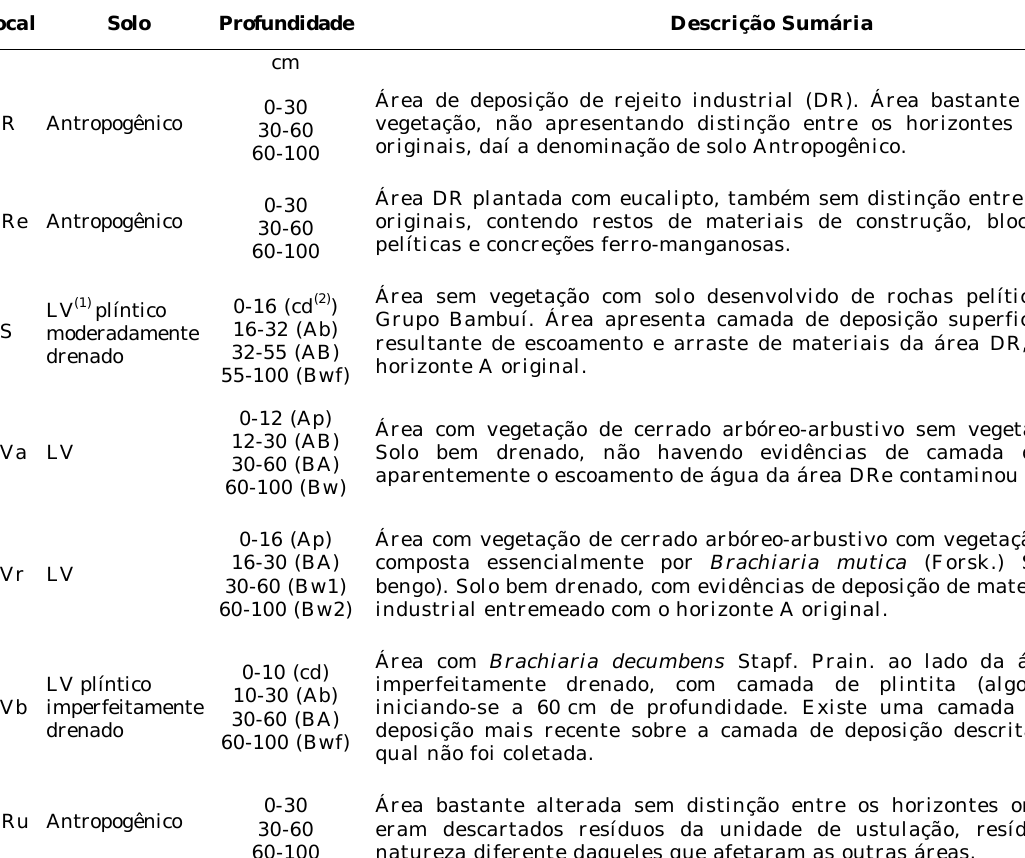
Quadro 1. Identificação dos locais amostrados na área em estudo, classes de solo, profundidades amostradas e breve descrição dos